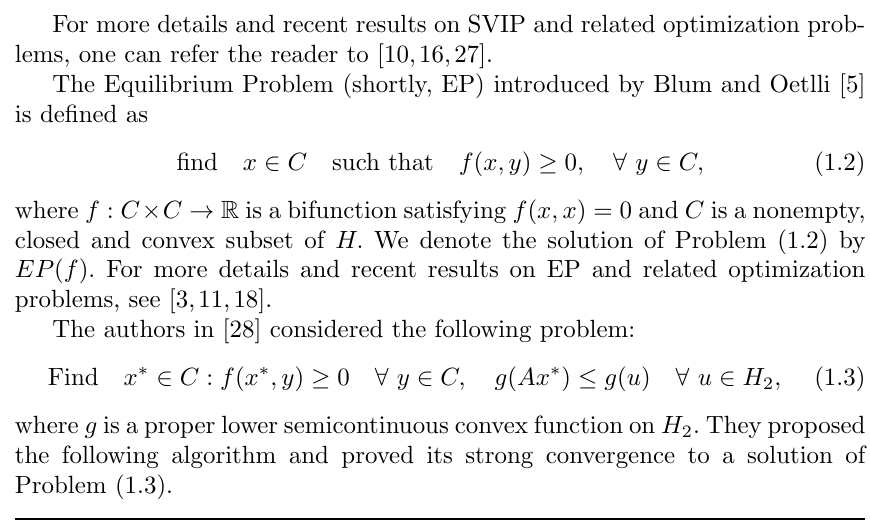
Algorithm 2. Mann-Krasnolselskii Proximal Algorithm